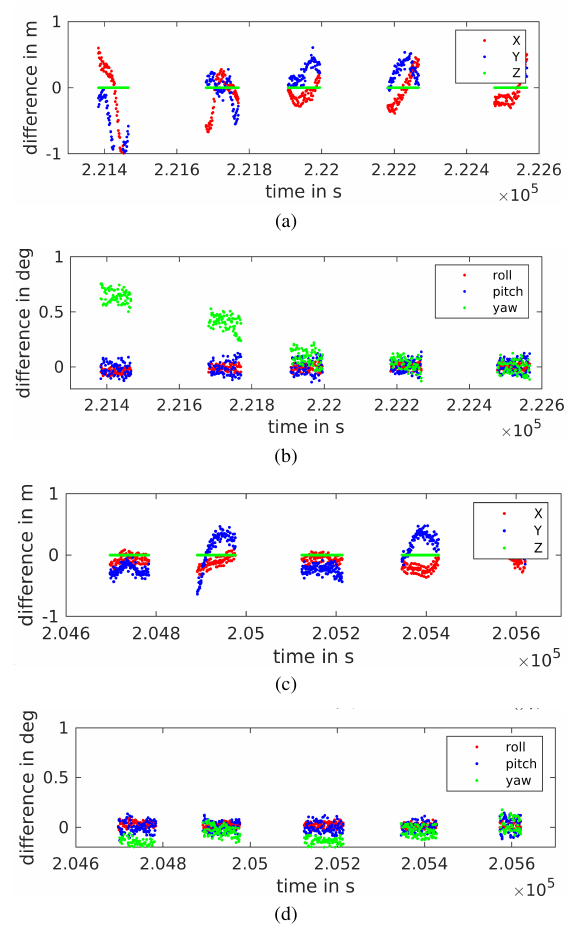
Figure 4. Differences between real-time and post-processed solutions for five curved flight lines a) and b) as well as for five straight flight lines c) and d) in the test